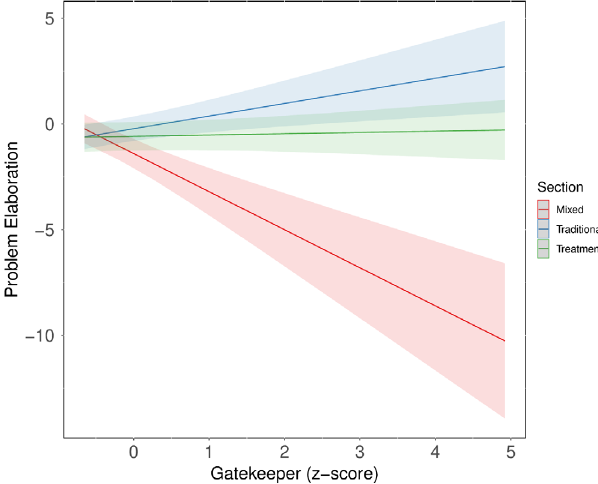
FIG. 7. Linear regression for interaction between gatekeeper and sections for predicting physics grades.